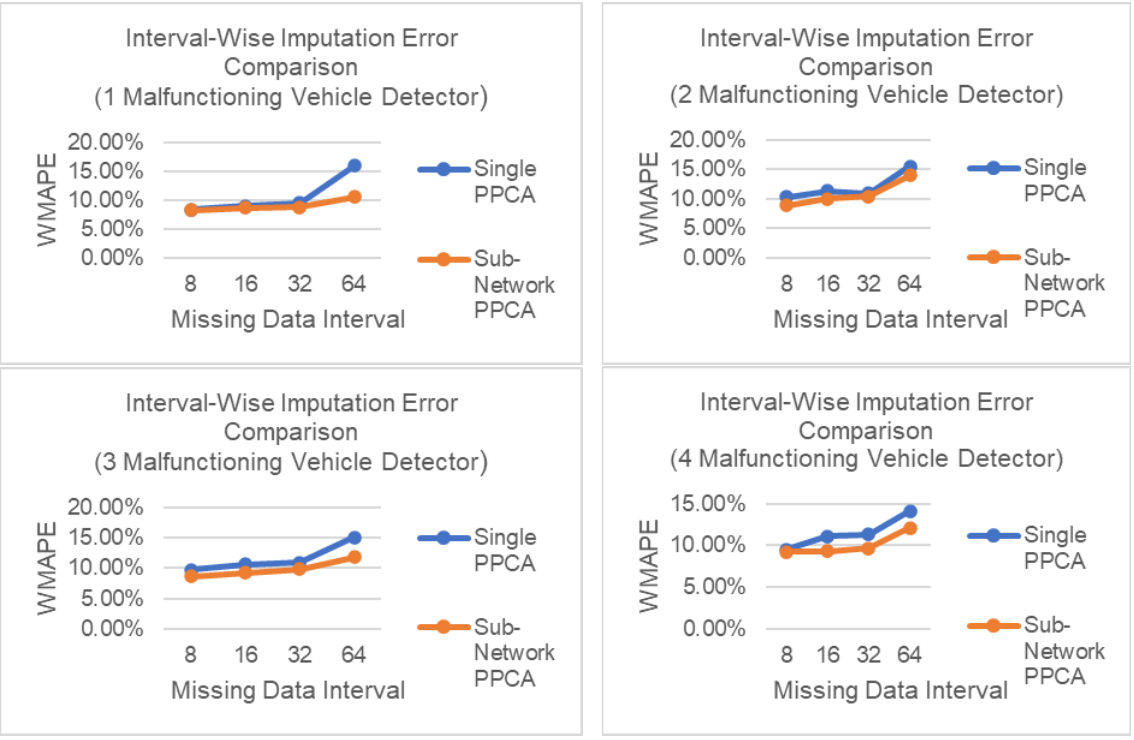
Figure 11. Scenario B Imputation error comparison for interval-wise missing data.